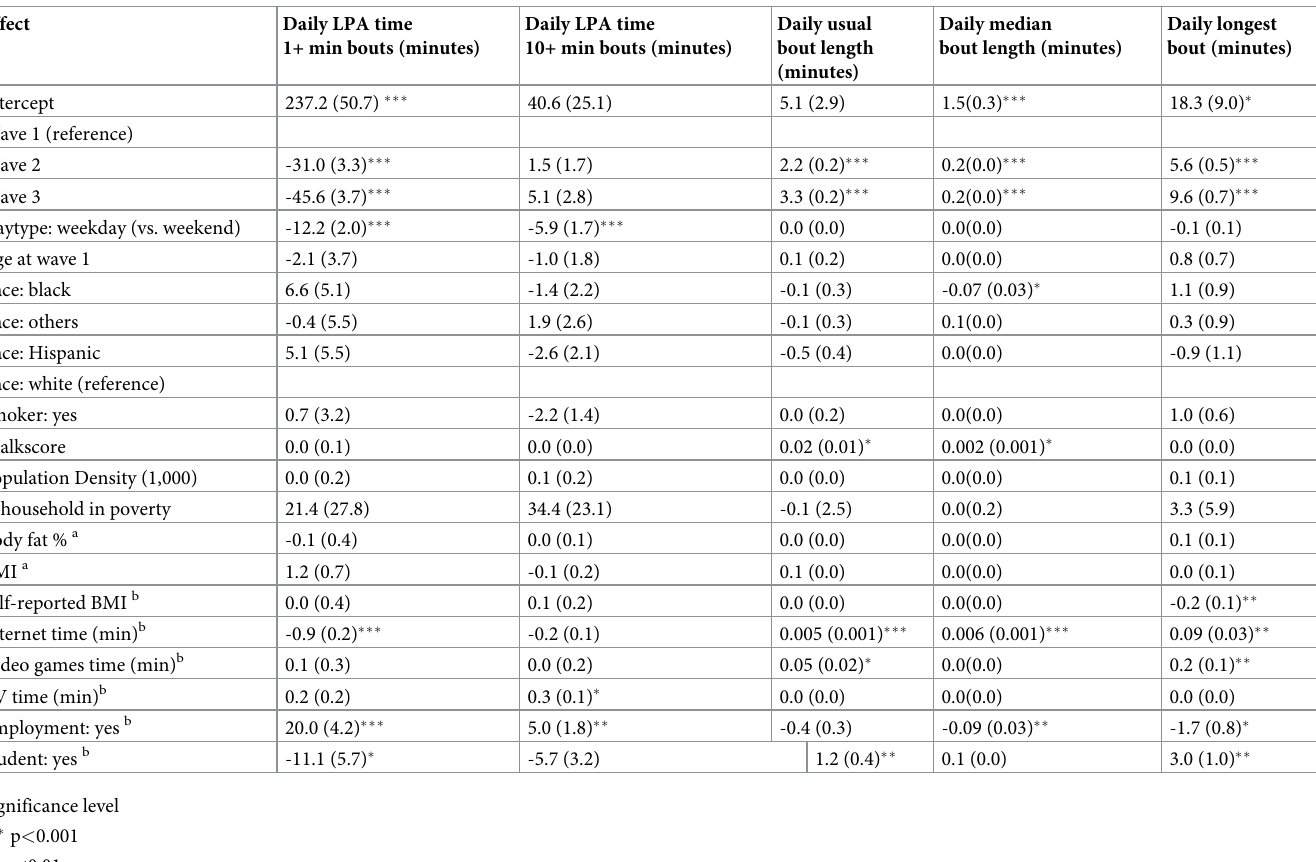
Table 3. Models estimating associations with patterns of light physical activity (standard error).